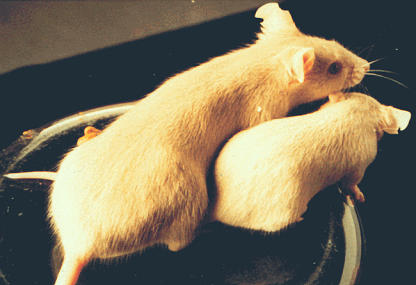
Variation in the expression of a protein involved in a rare human overgrowth syndrome contributes to size variation in mice (Photo: Lutz B&uuml;nger, Scottish Agricultural College)